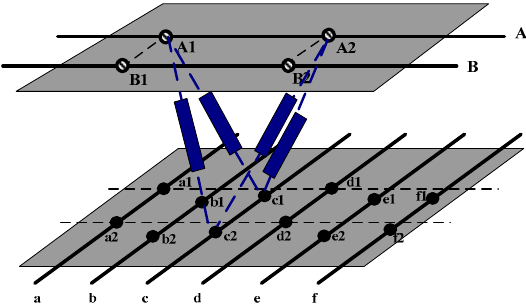
Figure 2. The parallel resistance model when no deformation has occurred.